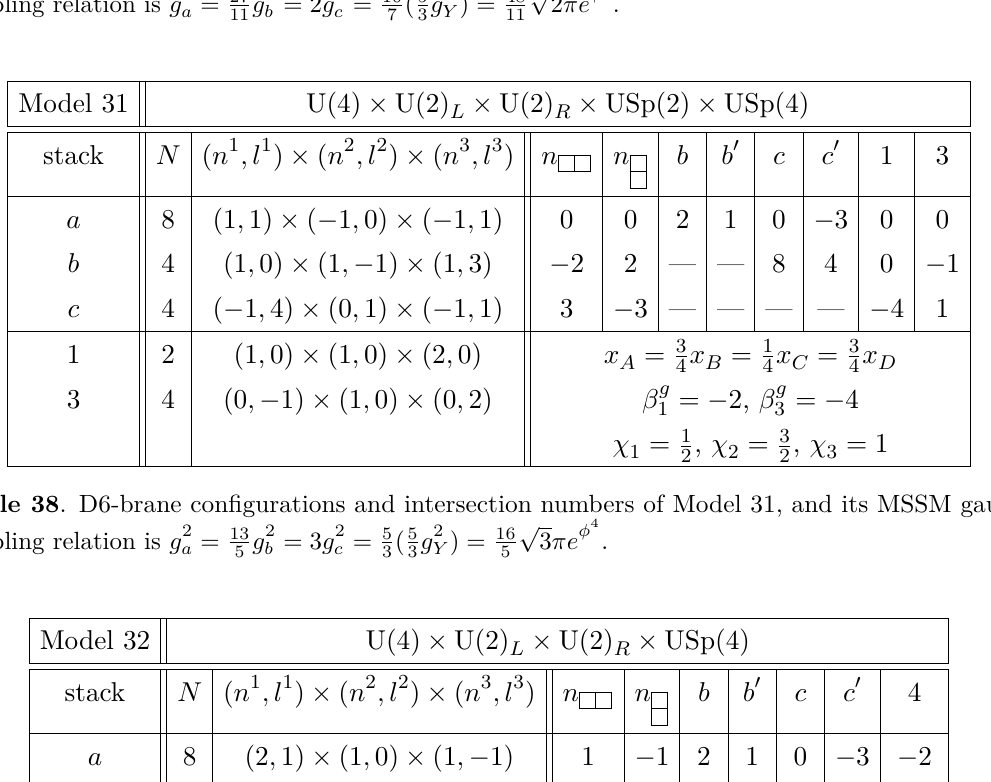
Table 37 . D6-brane configurations and intersection numbers of Model 30, and its MSSM gauge